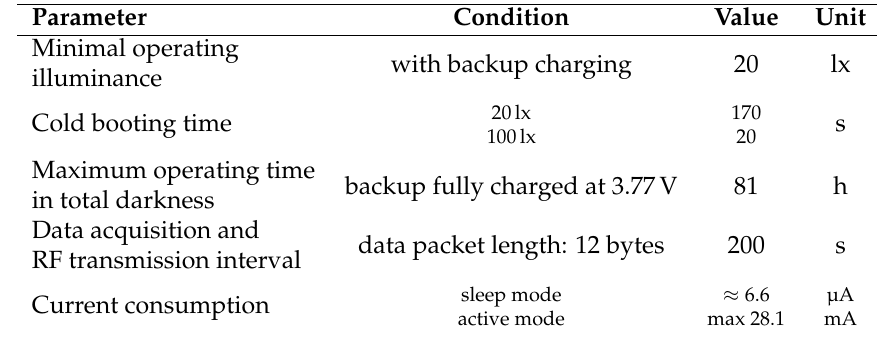
Table 2. Basic parameters of the photovoltaic energy harvesting device. Illumination levels under incandescent light